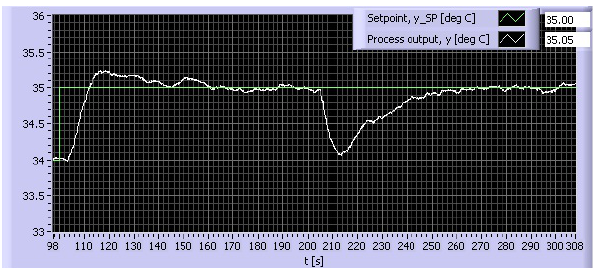
Figure 20: Good Gain method: The responses in the control system.